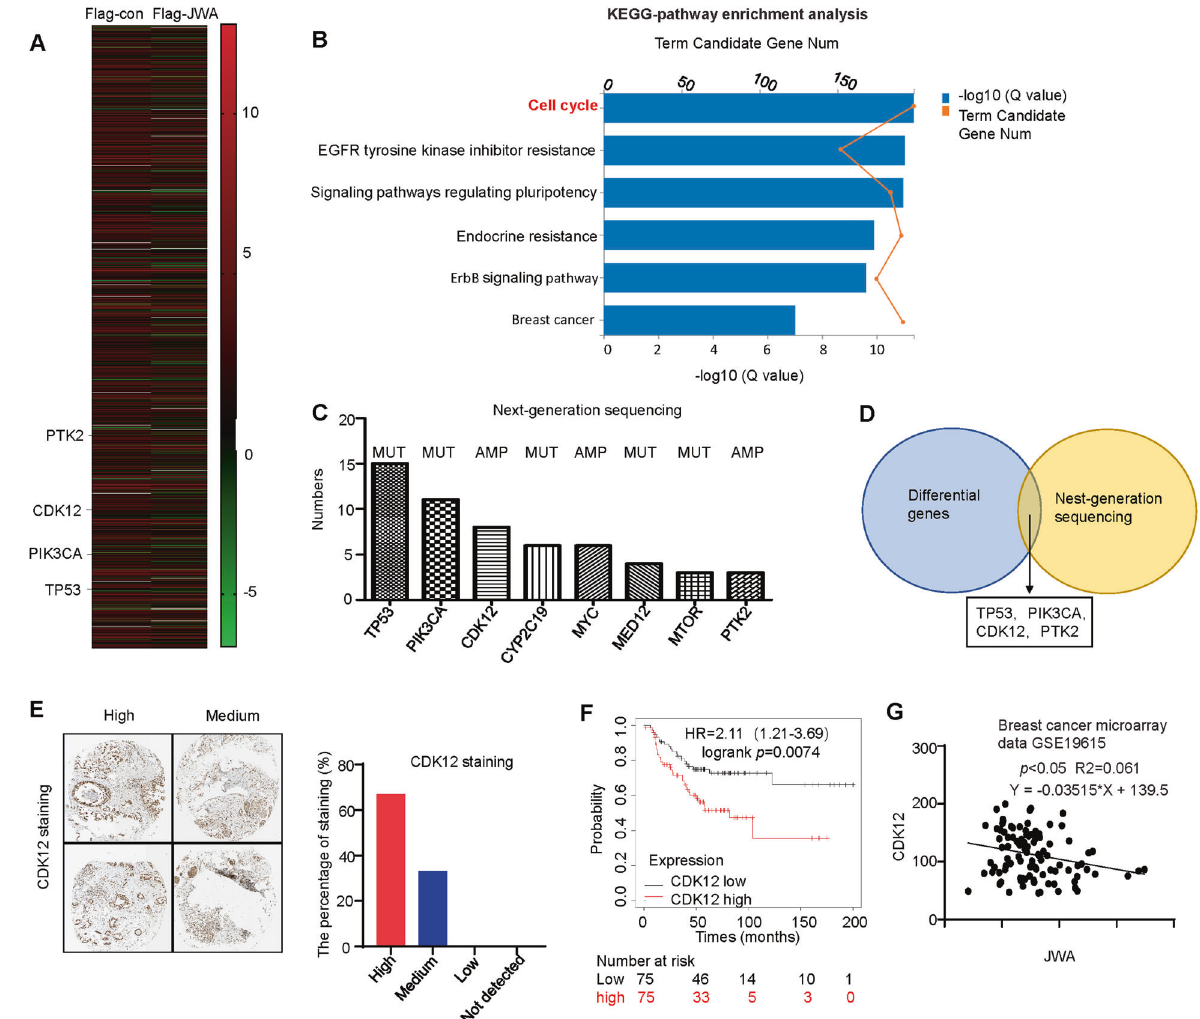
trastuzumab-resistant breast cancer patients subjected to NGS. D The intersection frequencies of genetic changes and NGS were ranked top 4 in the order of TP53, PIK3CA, CDK12, PTK2. E The IHC of 12 breast cancer patients through The Human Protein Atlas database, and CDK12 was highly expressed in eight patients and that was moderately expressed in four patients; (×40). F Survival curves showing a comparison of survival rates in patients with HER2 + breast cancer with low and high CDK12 expression. G Scatter plot showing the correlation between JWA and CDK12 expression in the breast cancer microarray data GSE19615. MUT mutation; AMP ampli fi